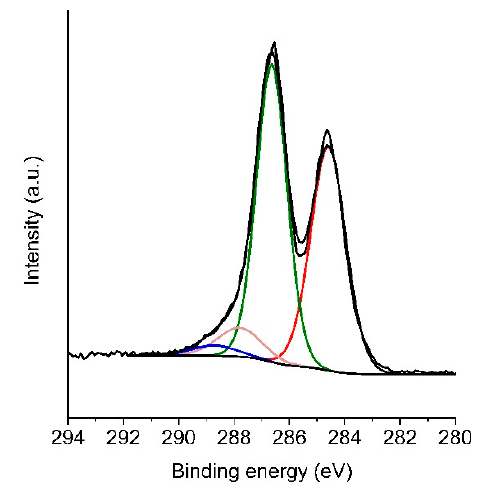
Figure A2. C1s spectra (XPS) of graphite oxide GO2.